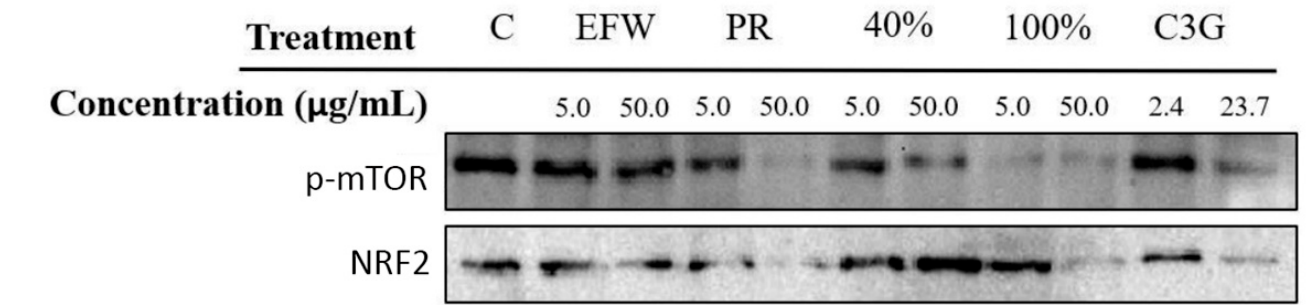
Figure 4. Specific Phenolic Fractions Reduce mTOR Phosphorylation and Increase NRF2 Protein Levels. Western blot analysis for phosphorylated mTOR (phospho-mTOR) (top panel) and NRF2 (bottom panel) protein following 72h exposure of 2DD cells to phenolic fractions at 2 concentrations (5 µ g/mL or 50 µ g/mL). C—control, EFW—ethanol:formic acid:water, PR—phenolic rich,